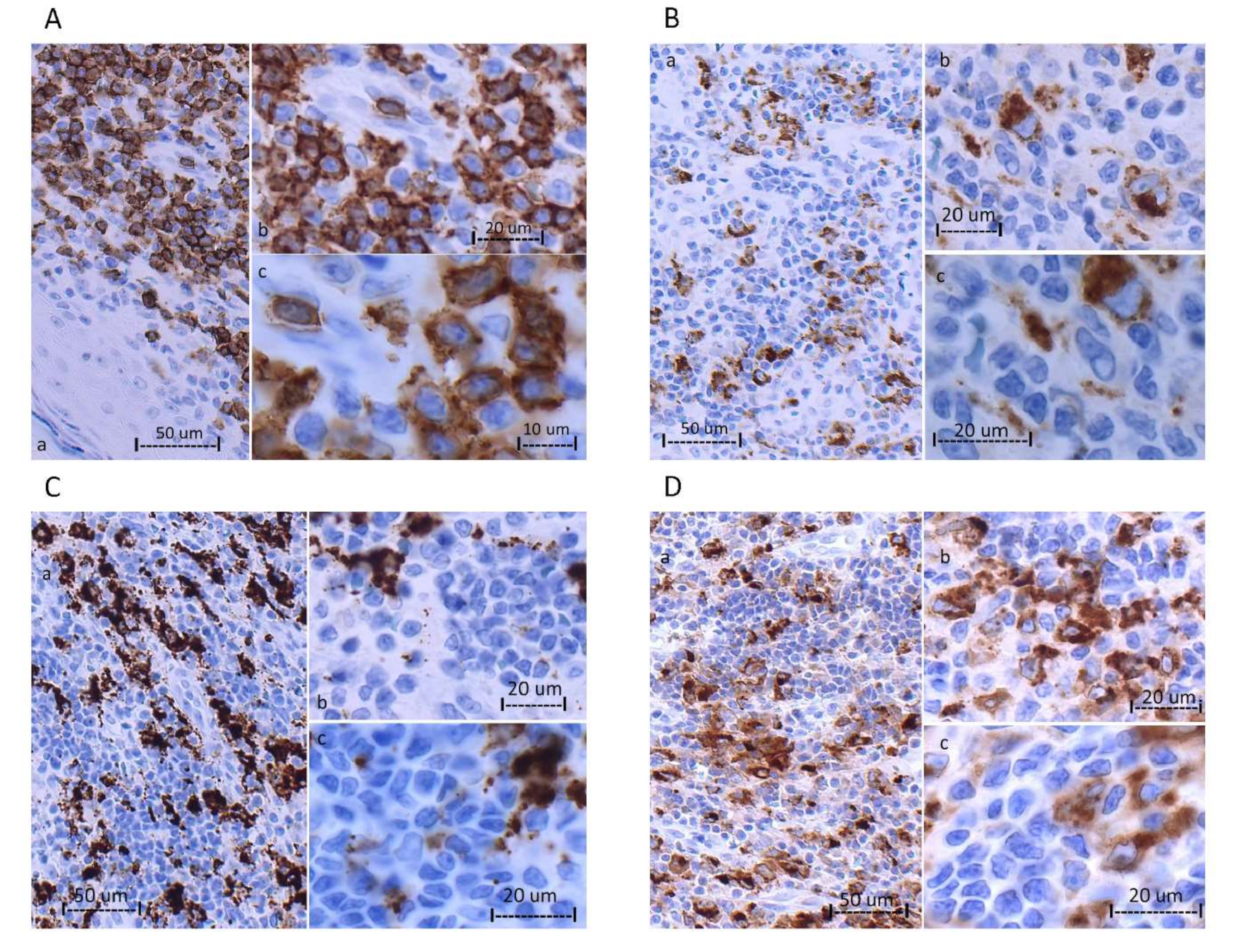
Figure 3. Photomicrographs of 2021 biopsy, histiocytic markers ( A ) CD8 highlights a rare epider- motropic focus. ( B ) CD68-KP1. ( C ) CD68-PGM1. ( D ) Lysozyme; panels a, b and c, 20 × , 40 × and 63 × oil. Histiocytic markers only highlight